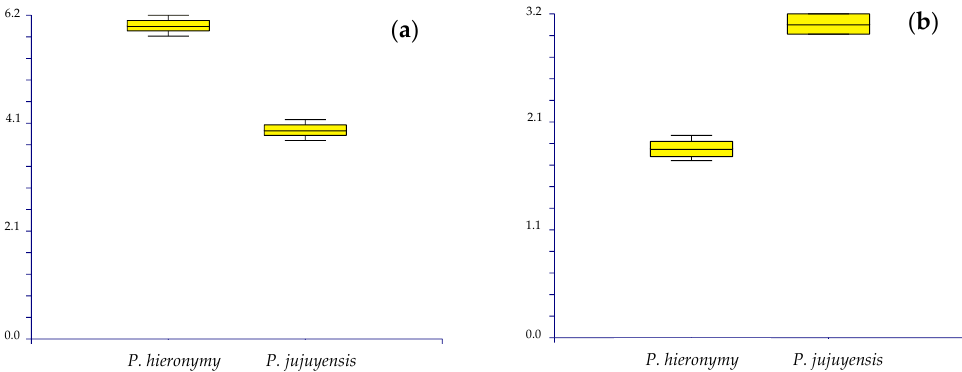
Figure 9. Paronychia jujuyensis vs. P. hieronymi . Box plots illustrating the variability of the diagnostic character: length of the flowers ( b ), length of the stipules ( a ). Yellow boxes illustrate interquartile ranges (=the range between the 25th and 75th percentile) and medians (horizontal line); vertical lines are the whiskers which represent the scores outside the middle 50% (i.e., the lower 25% of scores and the upper 25% of scores).